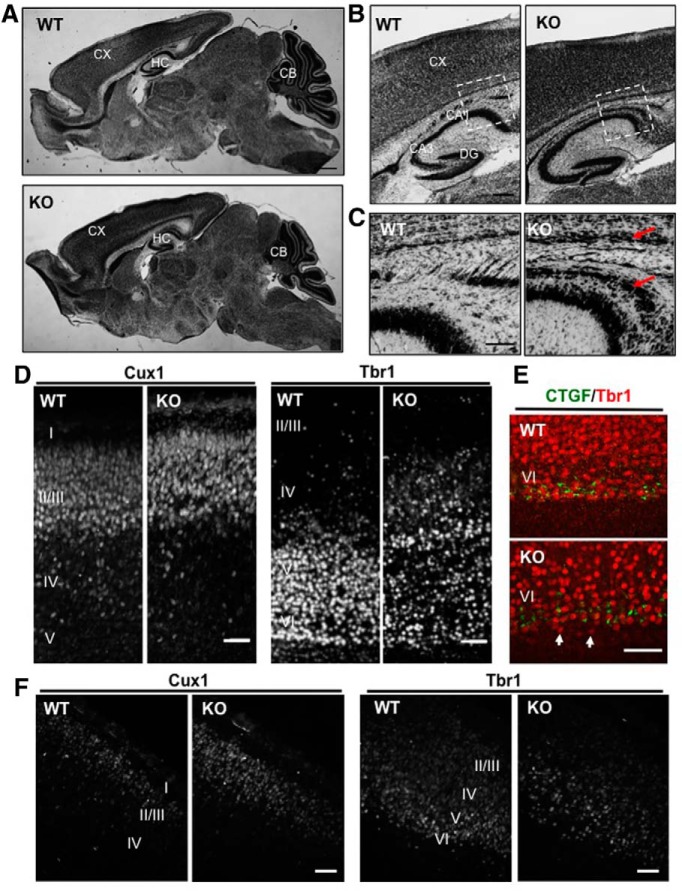
Anatomical analysis of forebrain structures in NEX-Tsc2 mice. A–C, Sagittal sections of P10 brain tissue from WT and KO mice were stained with thionin. A, All main brain regions appear normal at low magnification. B, C, Further magnified images of the mutant forebrain reveal the presence of an abnormally thick cellular layer in the deep neocortex, and dispersed pyramidal cells in hippocampal area CA1 (arrows). D, E, Layer marker analysis in the P0 neocortex. Sagittal sections were processed for immunofluorescence with the indicated antibodies. Cux1-positive upper layer neurons formed a normal, compact cellular layer, whereas Tbr1-positive deep layer neurons were somewhat dispersed in the KO sections compared with WT sections, and were sometimes positioned below the normally placed subplate neurons identified by the CTGF antibody (arrows). F, Layer marker analysis in the E14 neocortex. Coronal sections were processed for immunofluorescence with Cux1 or Tbr1 antibodies. Scale bars: A, 500 µm; B, 200 µm; C, 100 µm; D–F, 50 µm.